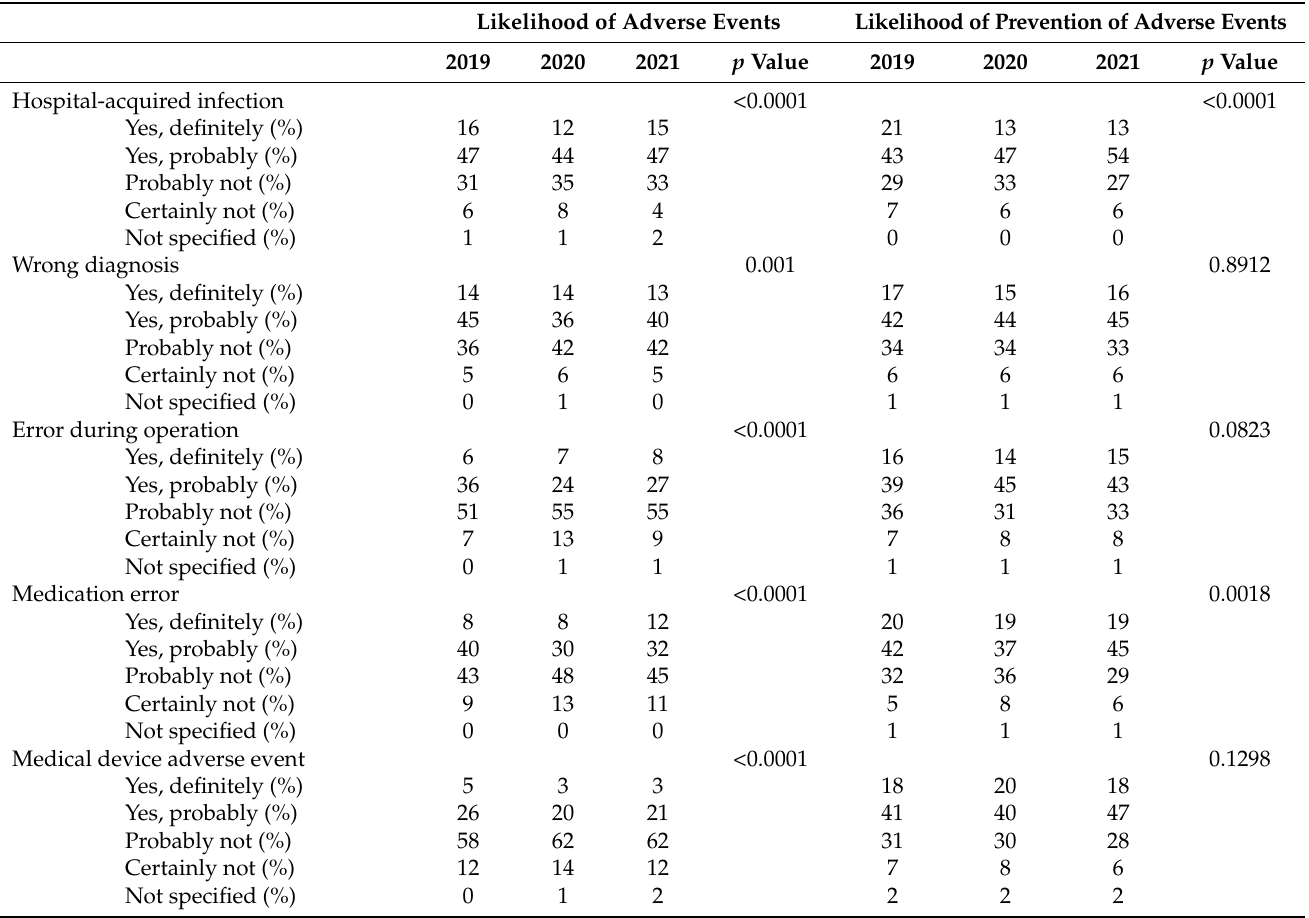
Figure 1. Participants perceptions of the likelihood of being harmed when receiving hospital and ambulatory care, 2019 to 2021 ( n = 1000 per year). Table 2. Participants’ perceptions of the likelihood of adverse events and their prevention, 2019 to 2021 ( n = 1000 per year).